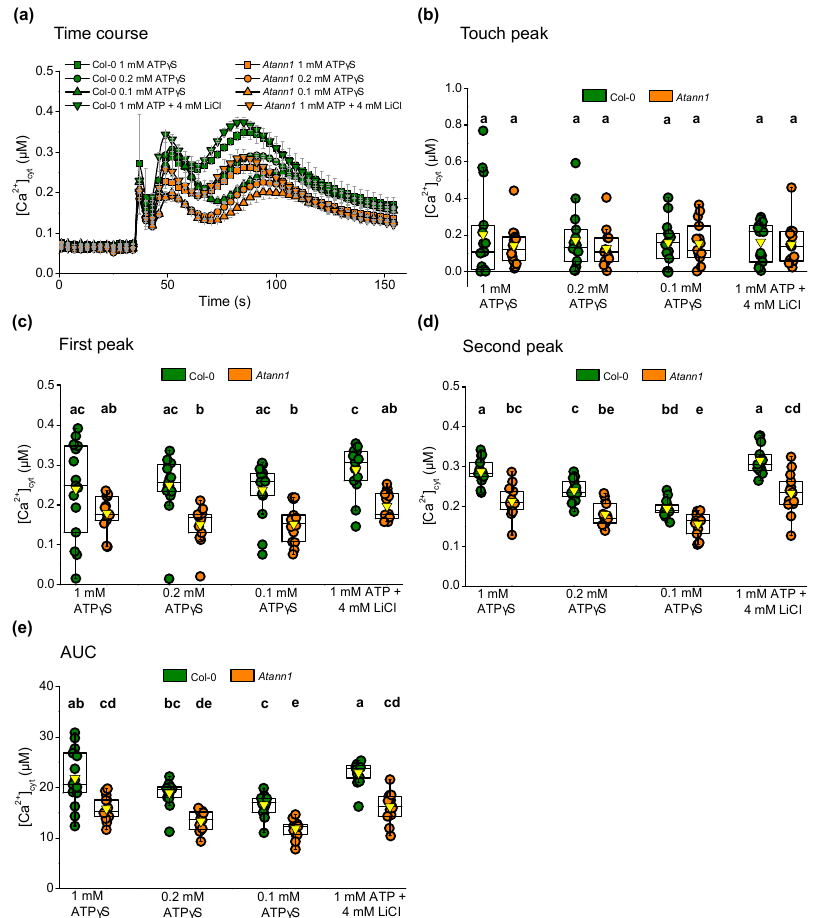
Figure 3. AtANN1 is crucial for the first peak [Ca 2+ ] cyt response at lower eATP concentration. ( a ) Mean (± SEM) [Ca 2+ ] cyt time course in response to different concentrations of eATP γ S or eATP with LiCl control from 3 experiments with n = 14–15 per genotype and treatment. ( b ) The [Ca 2+ ] cyt touch peak values (± SEM), ( c ) first peak [Ca 2+ ] cyt values (± SEM), ( d ) second peak [Ca 2+ ] cyt values (± SEM) and ( e ) the total [Ca 2+ ] cyt accumulated obtained from AUC (± SEM) for each concentration tested in both Col-0 and Atann1 extracted from the time course. p -values were obtained from ANOVA with Tukey’s post-hoc test or Kruskal-Wallis test for non-parametric approach. Different lower case letters indicate significant difference between means ( p < 0.05).